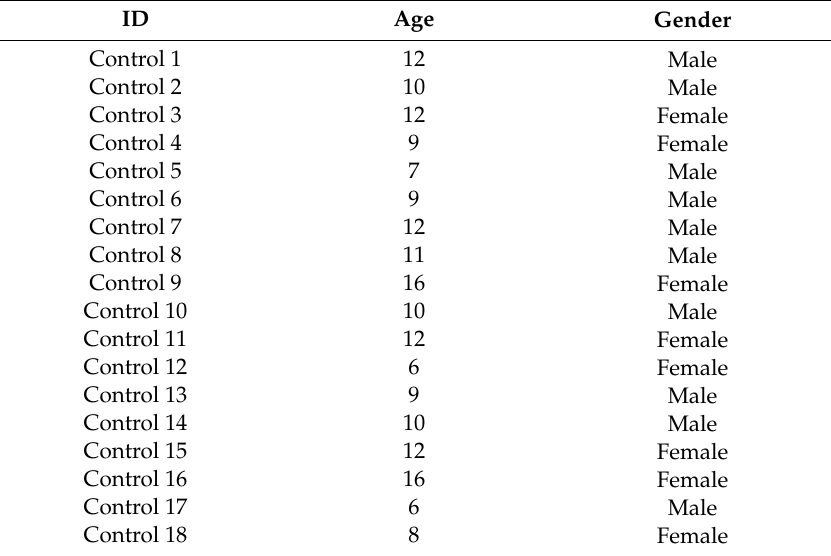
Table 2. Participant demographics for control